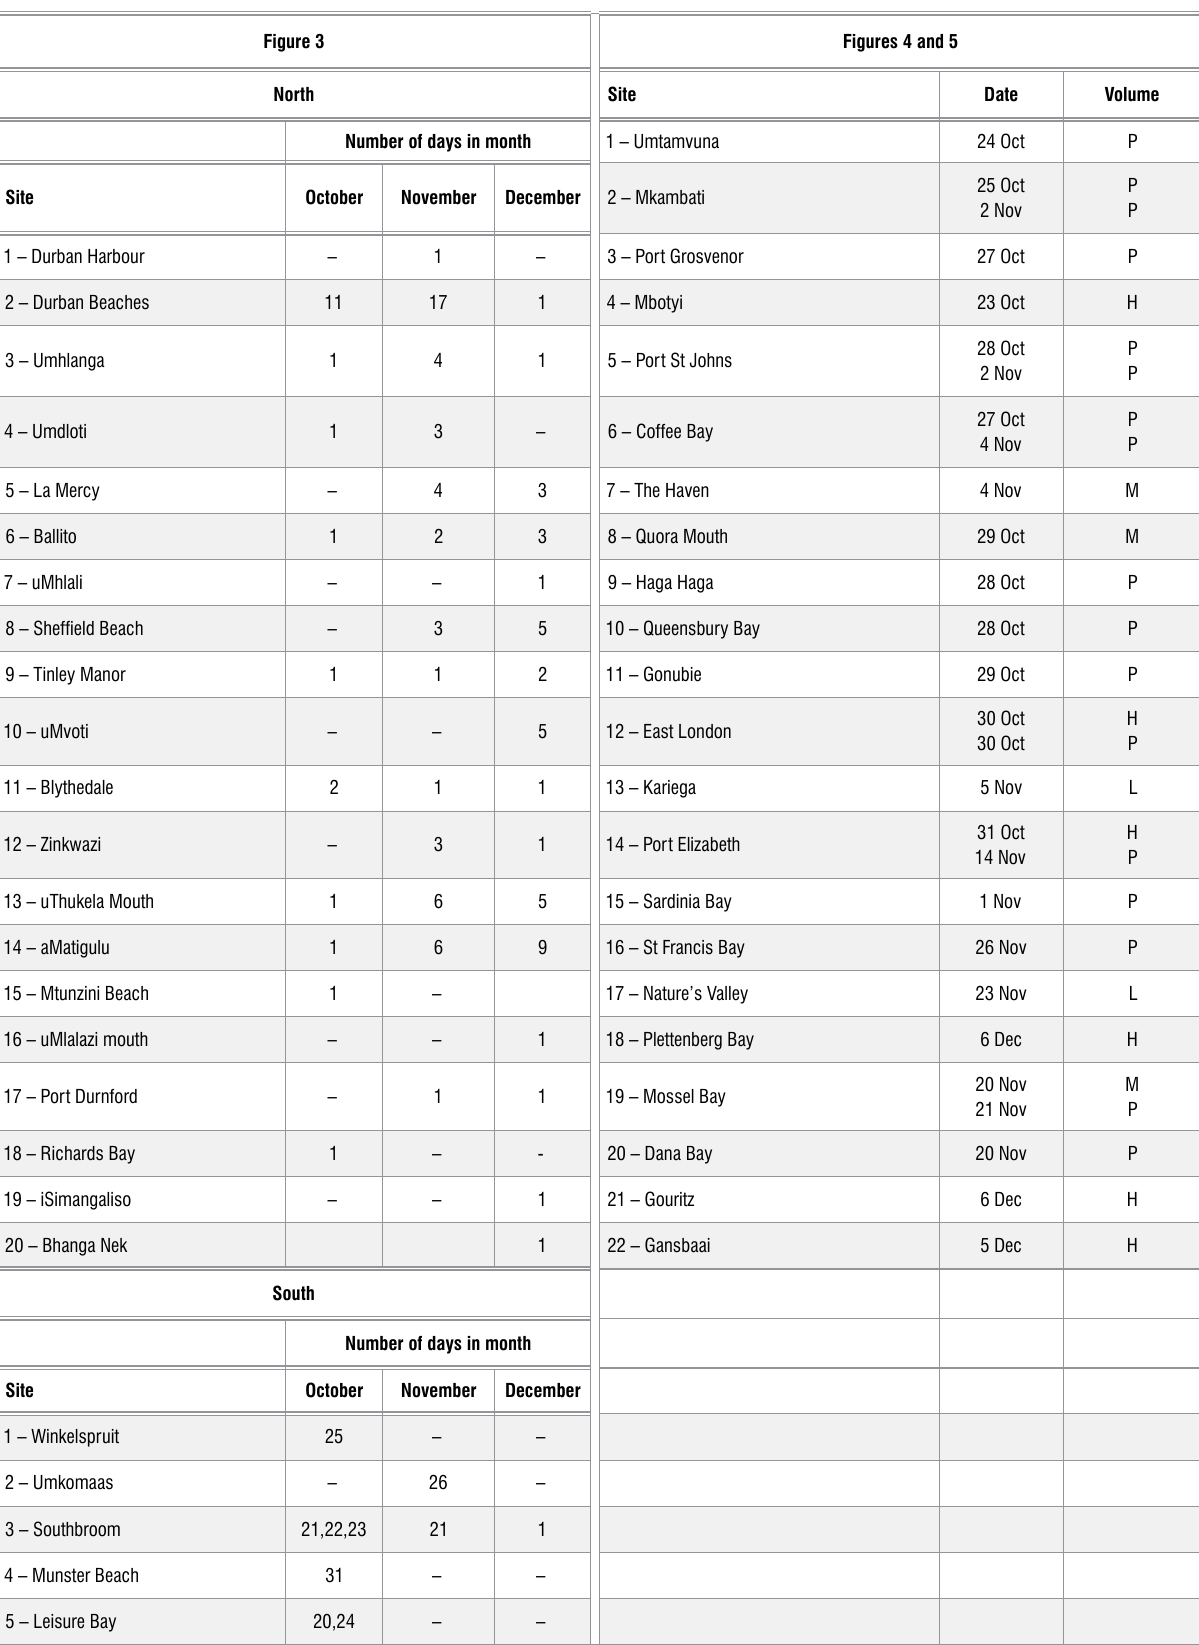
Reports of nurdle sightings by the public and collated by CoastKZN. The sites where reports were received are depicted in Figures 3, 4 and 5, with reported dates given; for Figures 4 and 5, the volume of nurdles found is indicated on the following basis: H, high; M, medium; L, low; P, present.